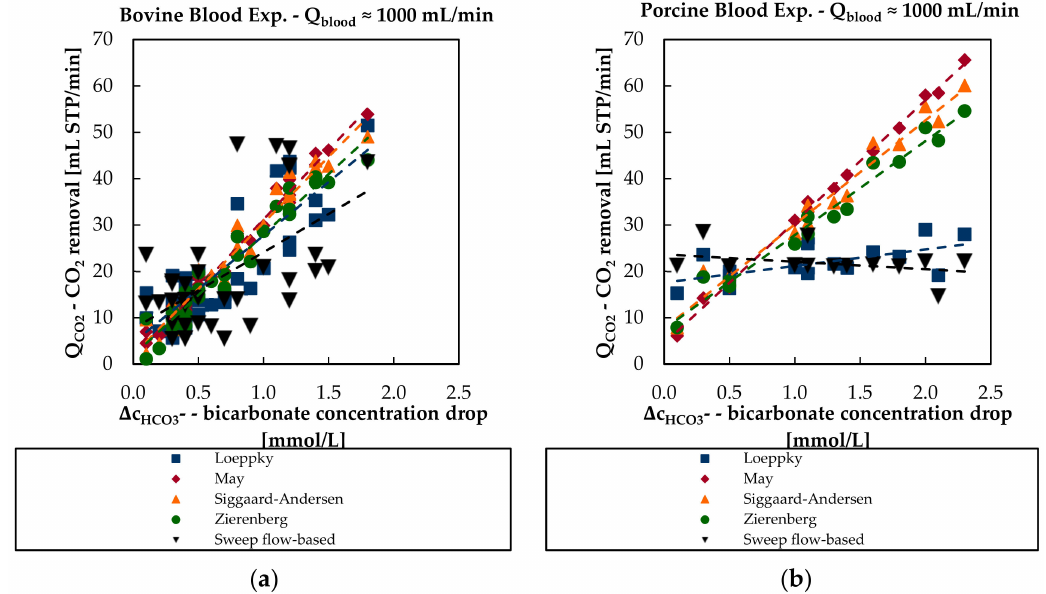
Figure 11. Sweep flow-based CO 2 removal and blood-based CO 2 removal rate of the four different CO 2 solubility models in dependency of the bicarbonate concentration drop over the membrane module: ( a ) in vitro bovine blood trials and ( b ) in vivo porcine blood trials.